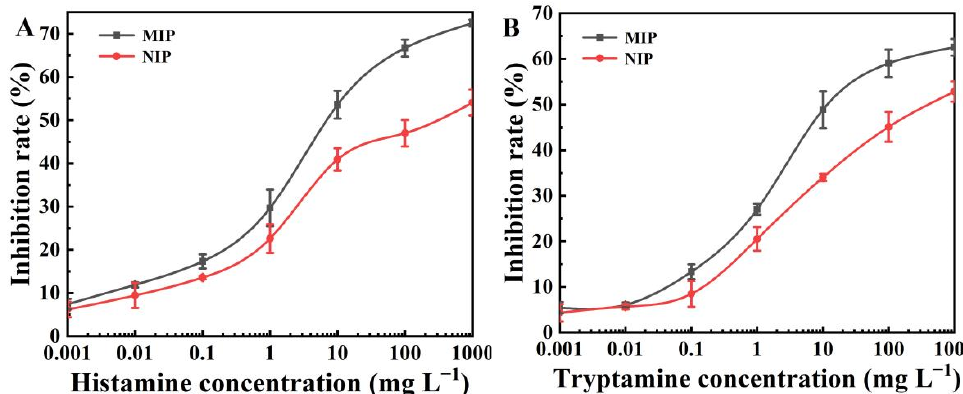
Figure 3. ( A ) BELISA standard curves for histamine using NIP and MIP as the artificial antibody; ( B ) BELISA standard curves for tryptamine using NIP and MIP as the artificial antibody.